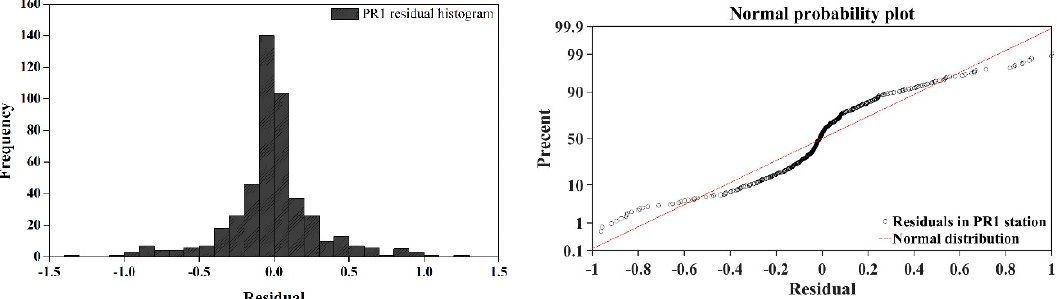
Figure 4. The histogram ( left column ) and normal probability plot ( right column ) of residuals at the PR1 station in the Pozi River basin.